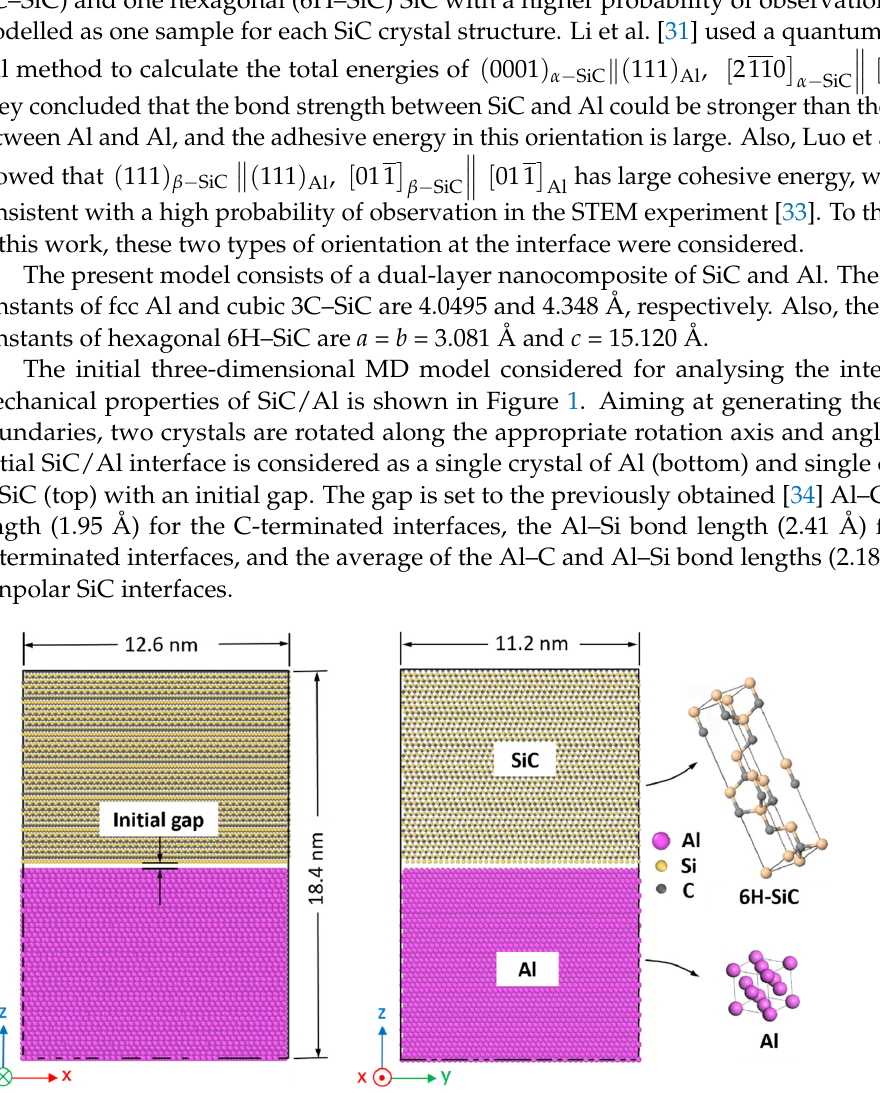
Figure 1. Schematic view of the Si-terminated 6H–SiC/Al interface model for the MD